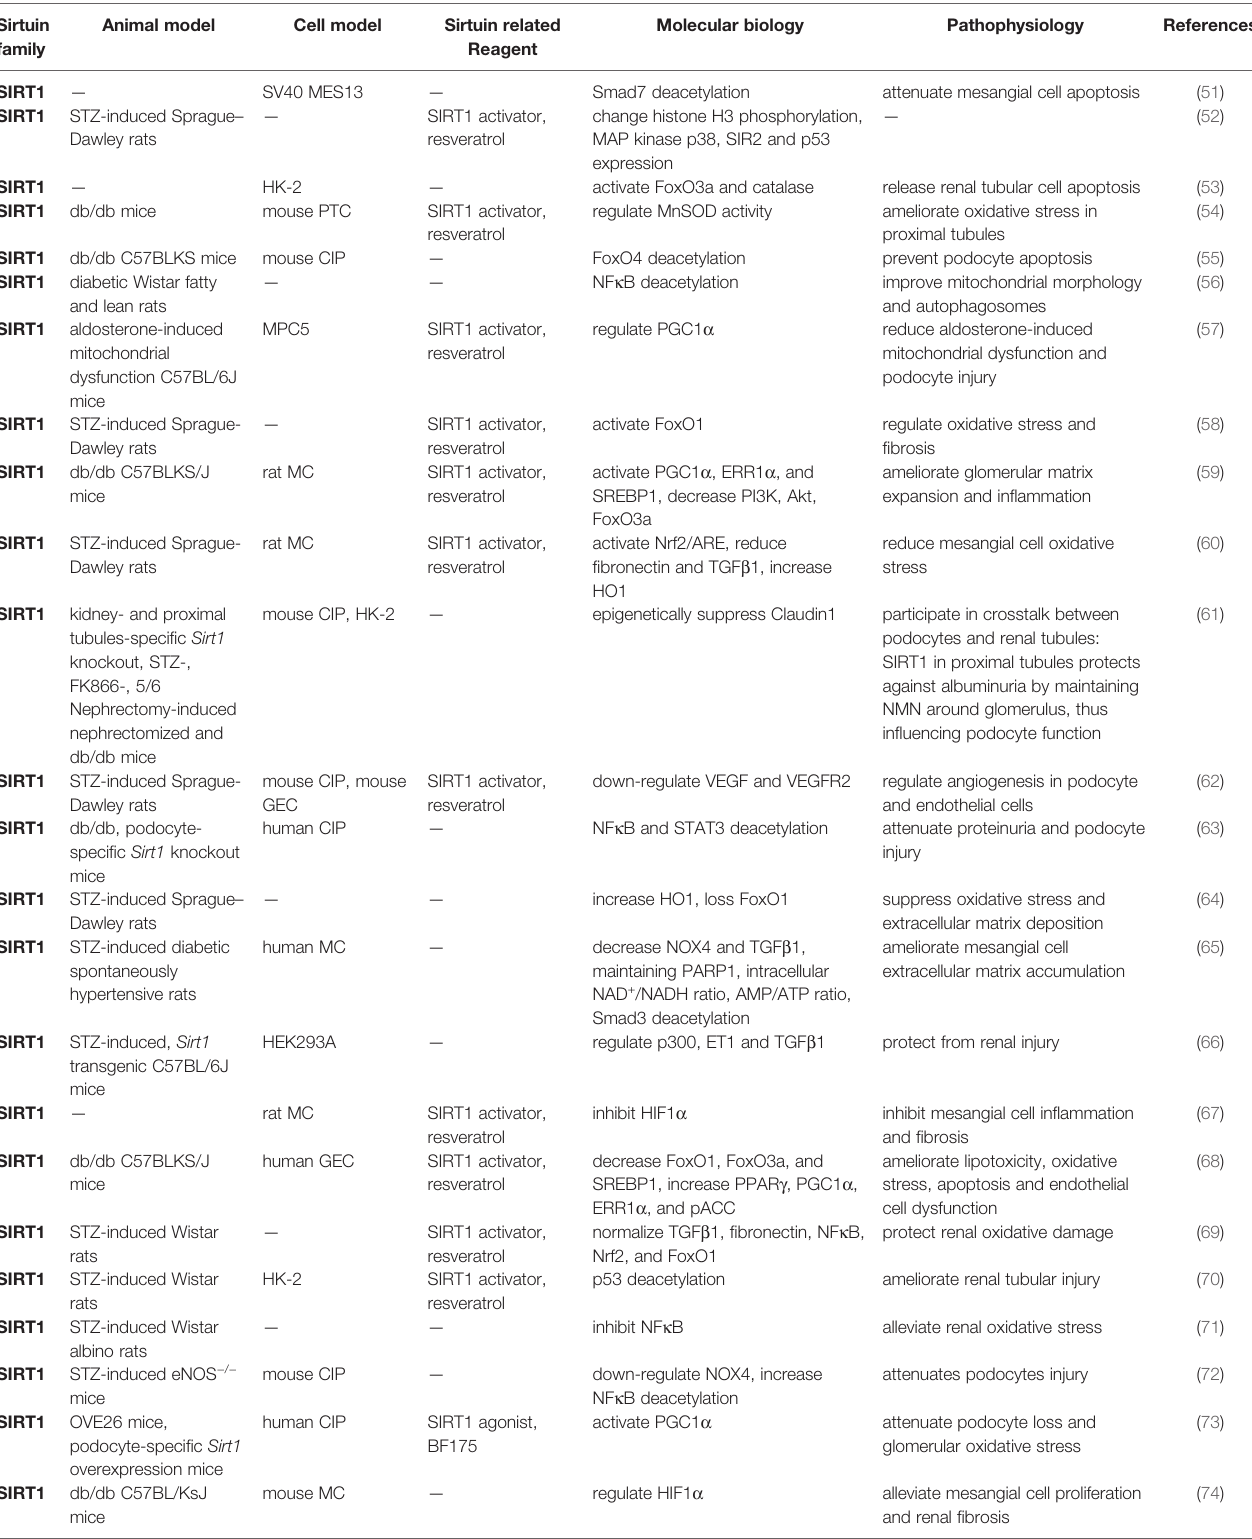
TABLE 2 | Role of Sirtuin family in diabetic kidney diseases. Sirtuin